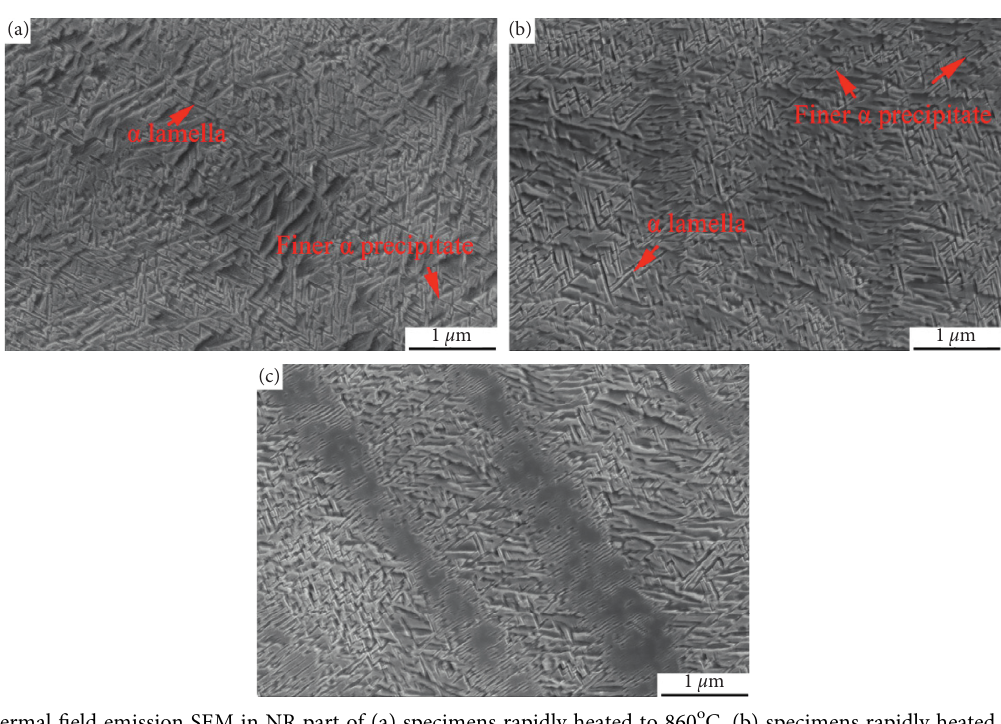
Figure 8: Thermal field emission SEM in NR part of (a) specimens rapidly heated to 860 o C, (b) specimens rapidly heated to 925 ° C, and (c) specimens rapidly heated to 940 ° C followed by ageing.